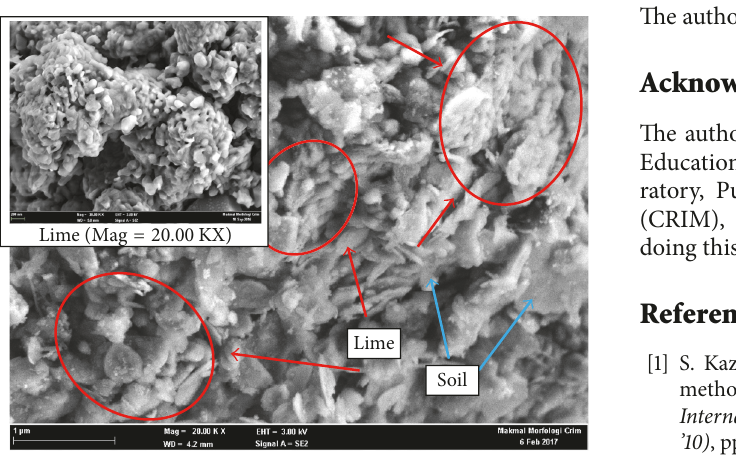
of soil mixed with 0.5% nanolime where it looks as a self- assembly or flocculation of gel-like particles, while soil mixed with 1% lime shown in Figures 11 and 12 looks like soft and the nanolime particles agglomerated more than that of lime.